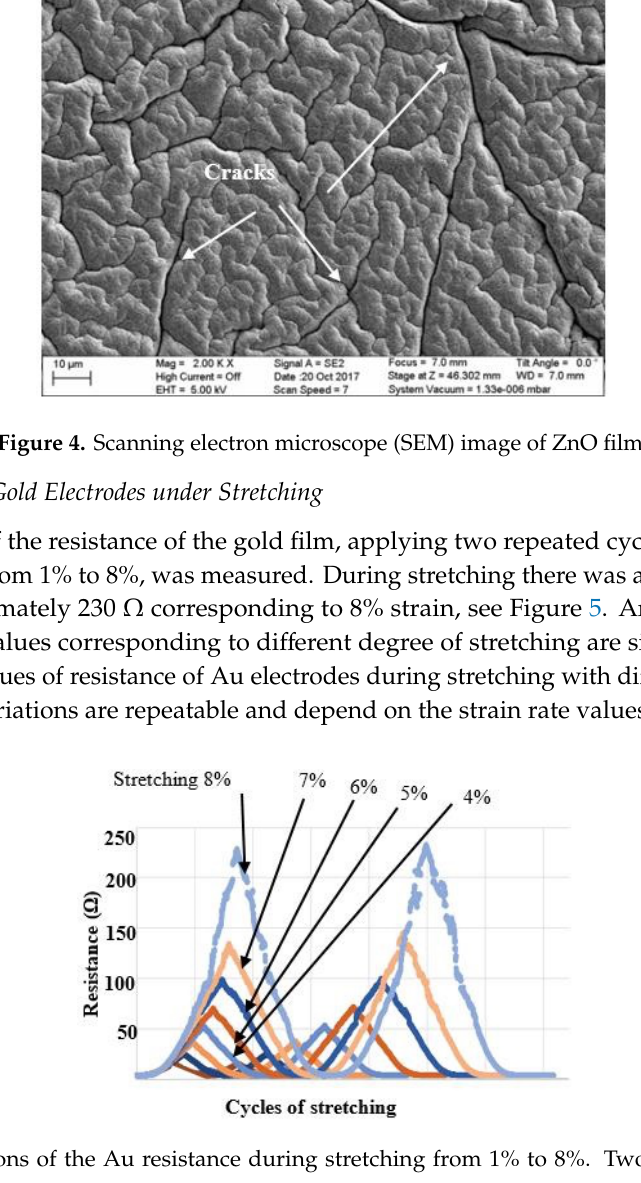
Figure 5. Variations of the Au resistance during stretching from 1% to 8%. Two stretching cycles are presented.